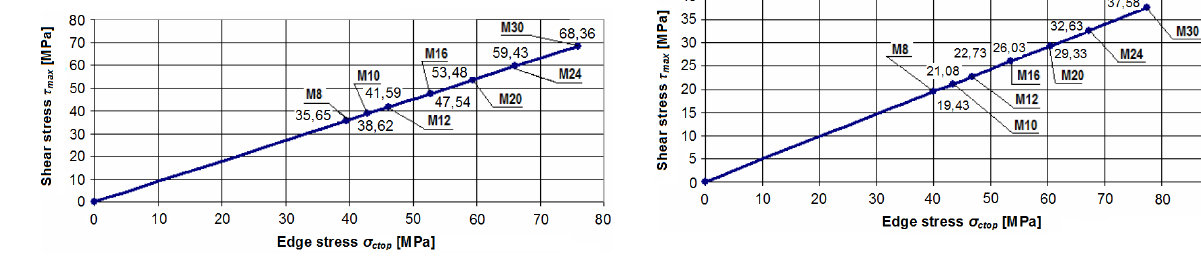
Figure 11: Dependency shear stress – edge stress for M8 ÷ M30 anchors in the stairwell slab.